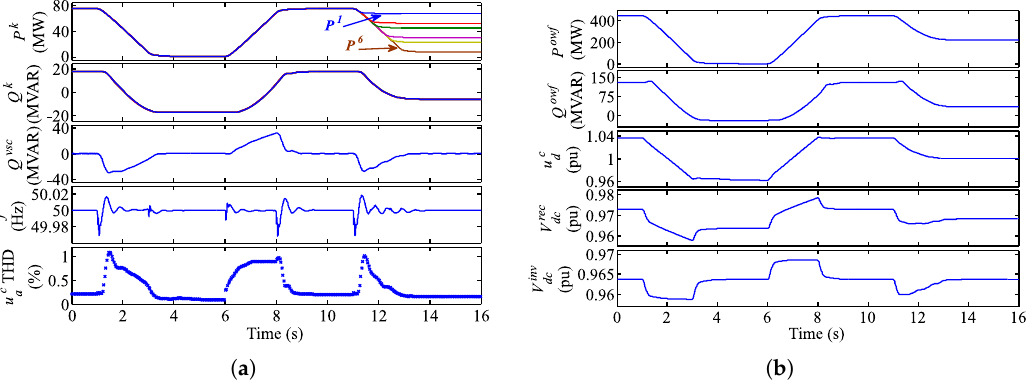
Figure 9. Transient control performance during the OWF active power changes: ( a ) WTs’ active and reactive powers, VSC reactive power, offshore ac-grid frequency and total harmonic distortion (THD) of phase a of the capacitor bank voltage; ( b ) OWF active and reactive powers, capacitor bank voltage magnitude, and the average values of the rectifier and onshore inverter